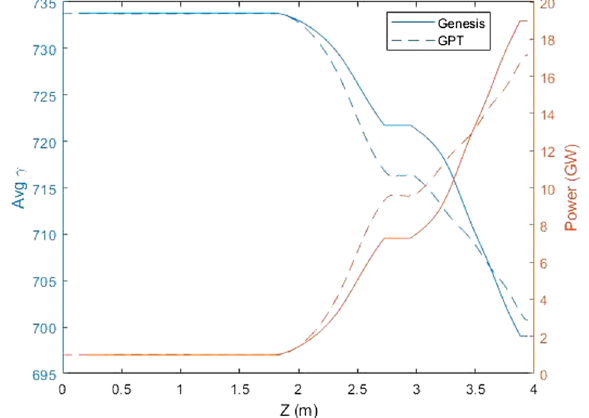
FIG. 7. Energy exchange in the first two tapered undulators of the TESSA beamline.